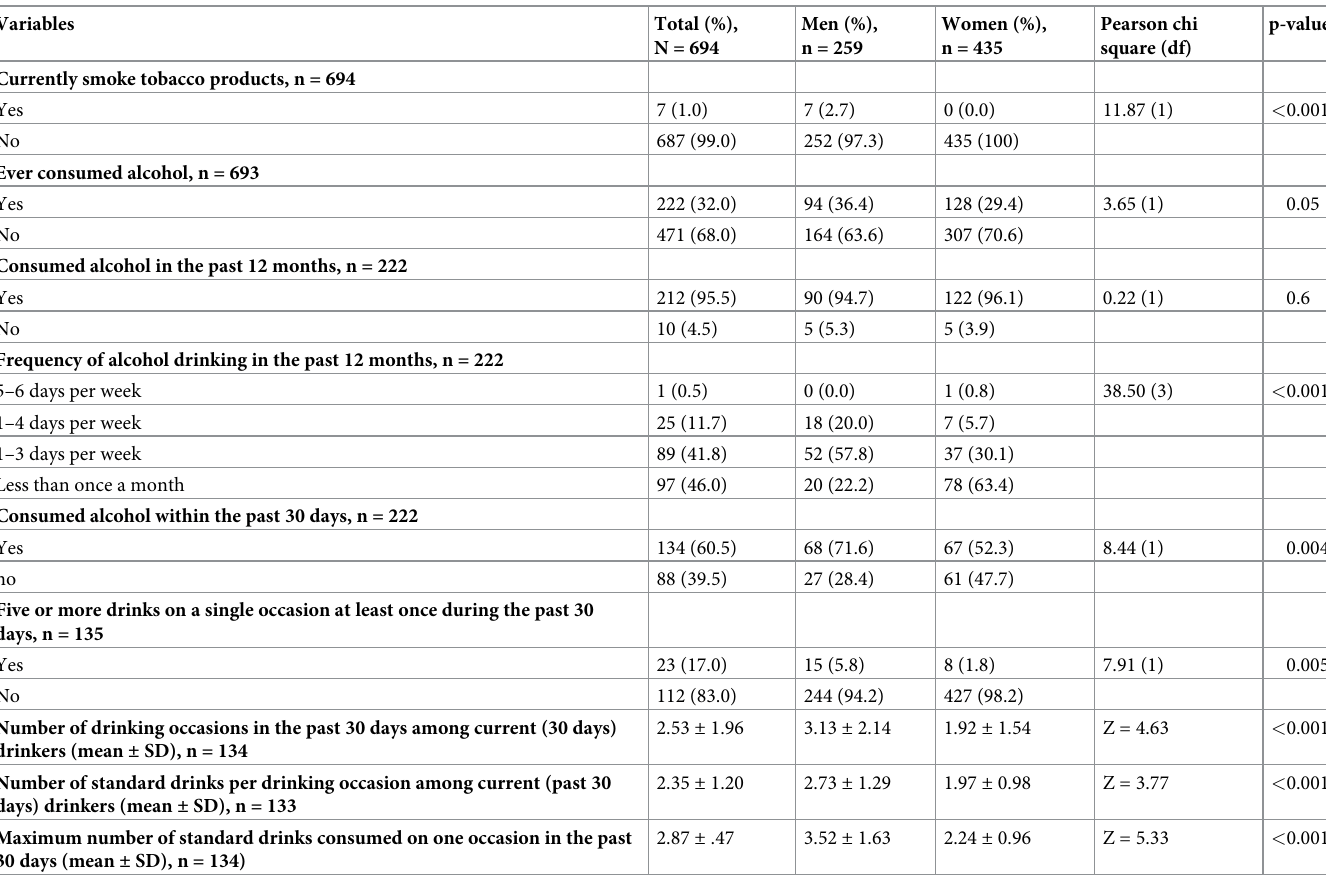
Table 3. Alcohol and tobacco consumption behavior of study participants in administrative towns of Bale zone, Southeast Ethiopia, 2021.